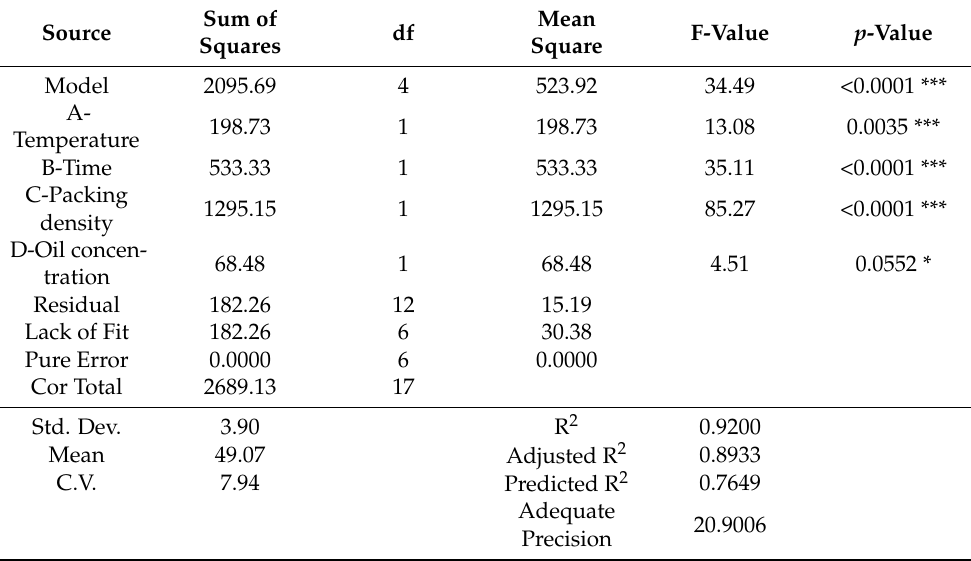
Table 4. Analysis of variance (ANOVA) of the Plackett Burman design (PBD) model used to identify the factor significantly influencing diesel